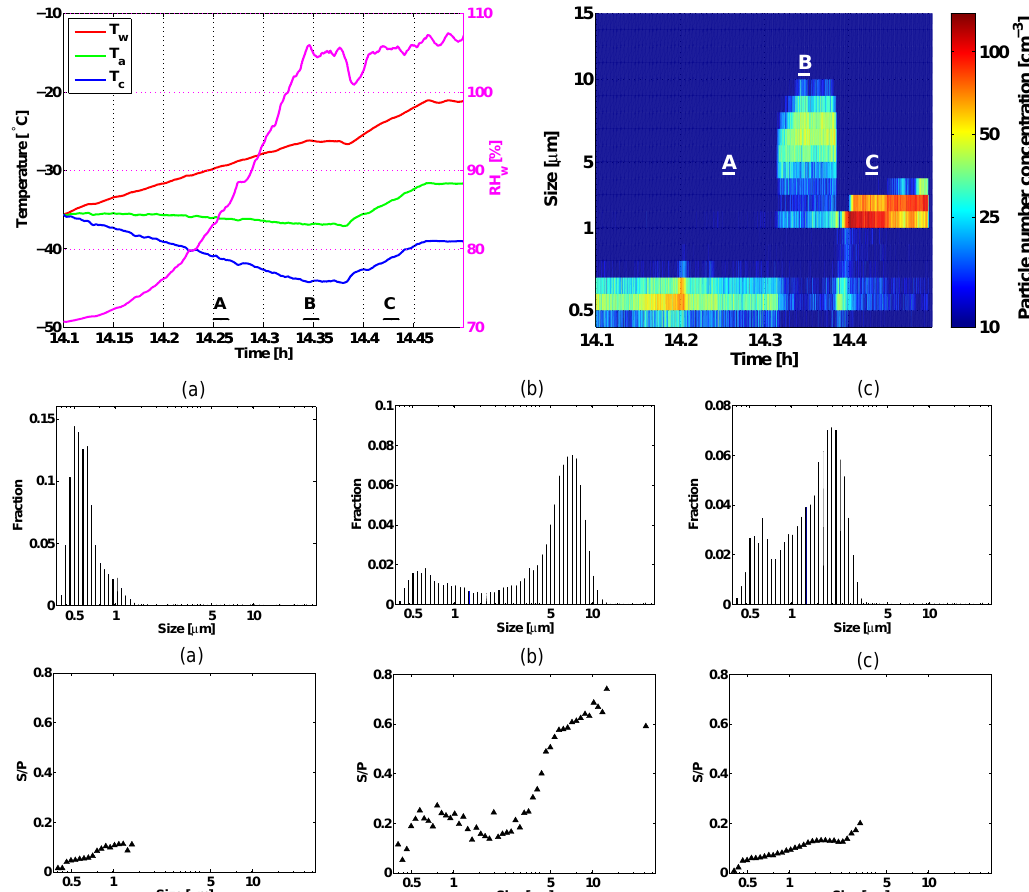
Figure 1. Homogeneous freezing of highly diluted ammonium sulphate droplets. In the top left panel, the SPIN cold and warm wall ( T c and T w ) and sample (lamina) temperatures ( T a ), as well as the relative humidity with respect to liquid water (RH w ) are plotted as a function of time. The top right panel shows the particle number concentrations in different size bins from the same experiment. Bars A, B, C in the top panels mark the time intervals from which the normalized SPIN OPC particle number size distributions and the median values of the polarization-equivalent S/P ratios are shown in the corresponding lower panels. In (a) seed particles, in (b) seed and ice particles, in (c) seed particles and liquid droplets. The size distributions and S/P ratios are averaged over 54s, and correspond to the following times in the upper panels: (a) 14.25–14.265h, (b) 14.34–14.355h, (c)